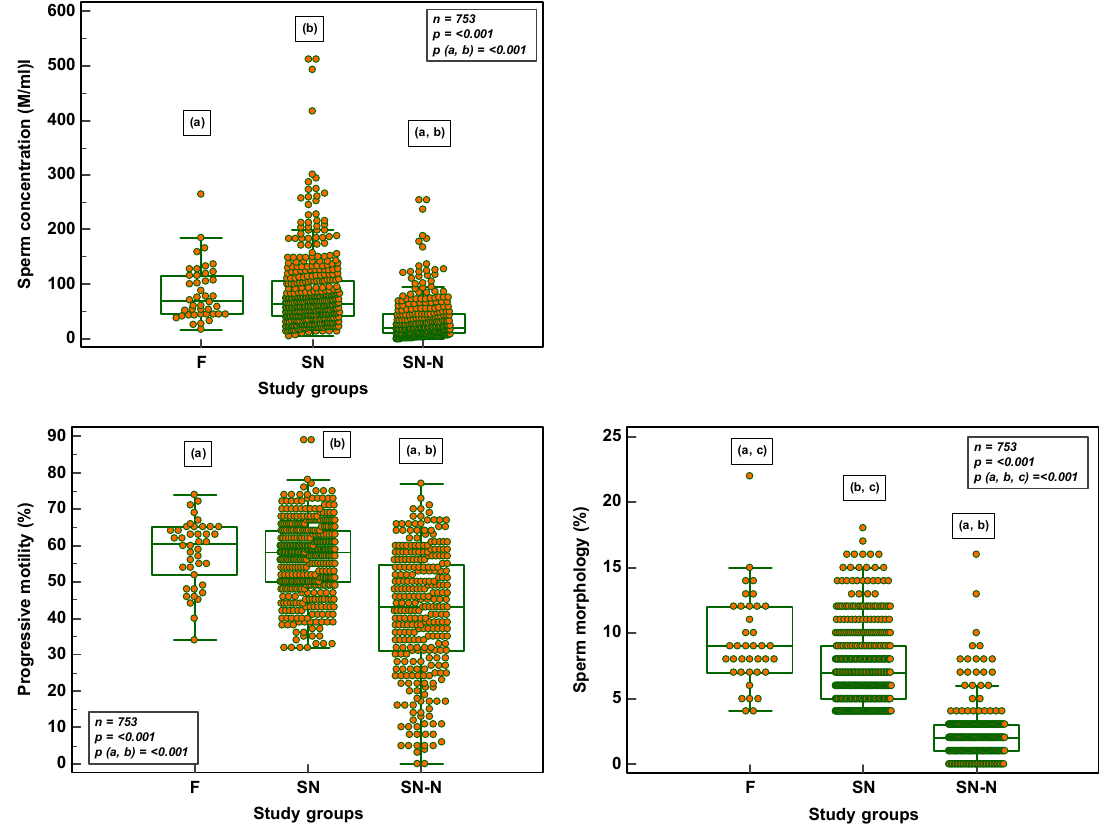
Figure 2. Semen parameters in the different study groups (F = fertile population; SN = subfertile population with normozoospermia; SN-N = subfertile non-normozoospermic population). 3.2. SDF Parameters in Fertile, Subfertile Normozoospermic and Subfertile Non-normozoospermic Males Total SDF was significantly negatively correlated (r = − 0.14; p ≤ 0.001) with progres- sive motility and vital SDF (r = − 0.08; p ≤ 0.001) with sperm concentration (Figure 3).